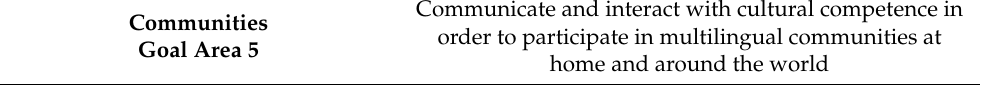
Table 1. Communities Goal Area (W-RSLL 2015). Communicate and interact with cultural competence in Communities order to participate in multilingual communities at Goal Area 5 home and around the world School and Global Communities Standard